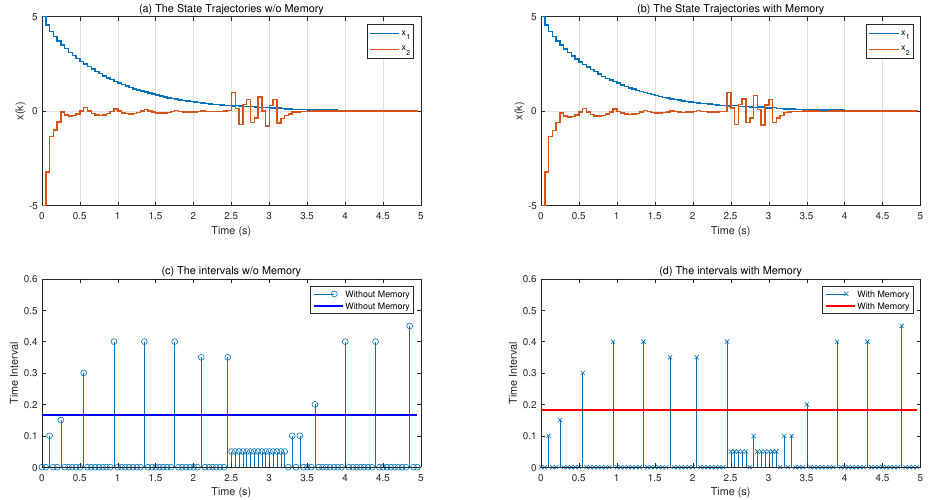
Figure 10. The state trajectories and intervals for with and without memory control. ( a ) The state response of the systems without memory control; ( b ) the state response of the systems with memory; ( c ) the intervals between transmitted signals without memory control; ( d ) the intervals between transmitted signals without memory control.